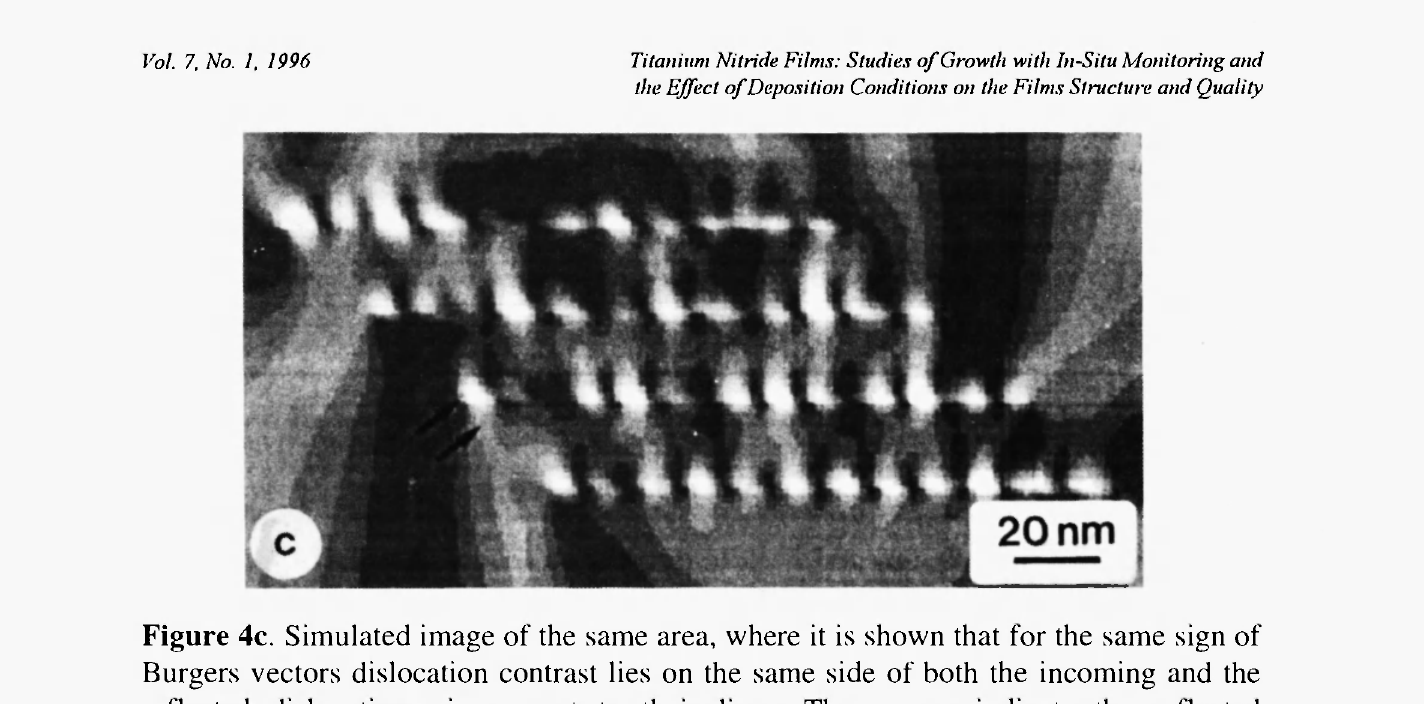
Figure 4c. Simulated image of the same area, where it is shown that for the same sign of Burgers vectors dislocation contrast lies on the same side of both the incoming and the reflected dislocations, in respect to their lines. The arrows indicate the reflected